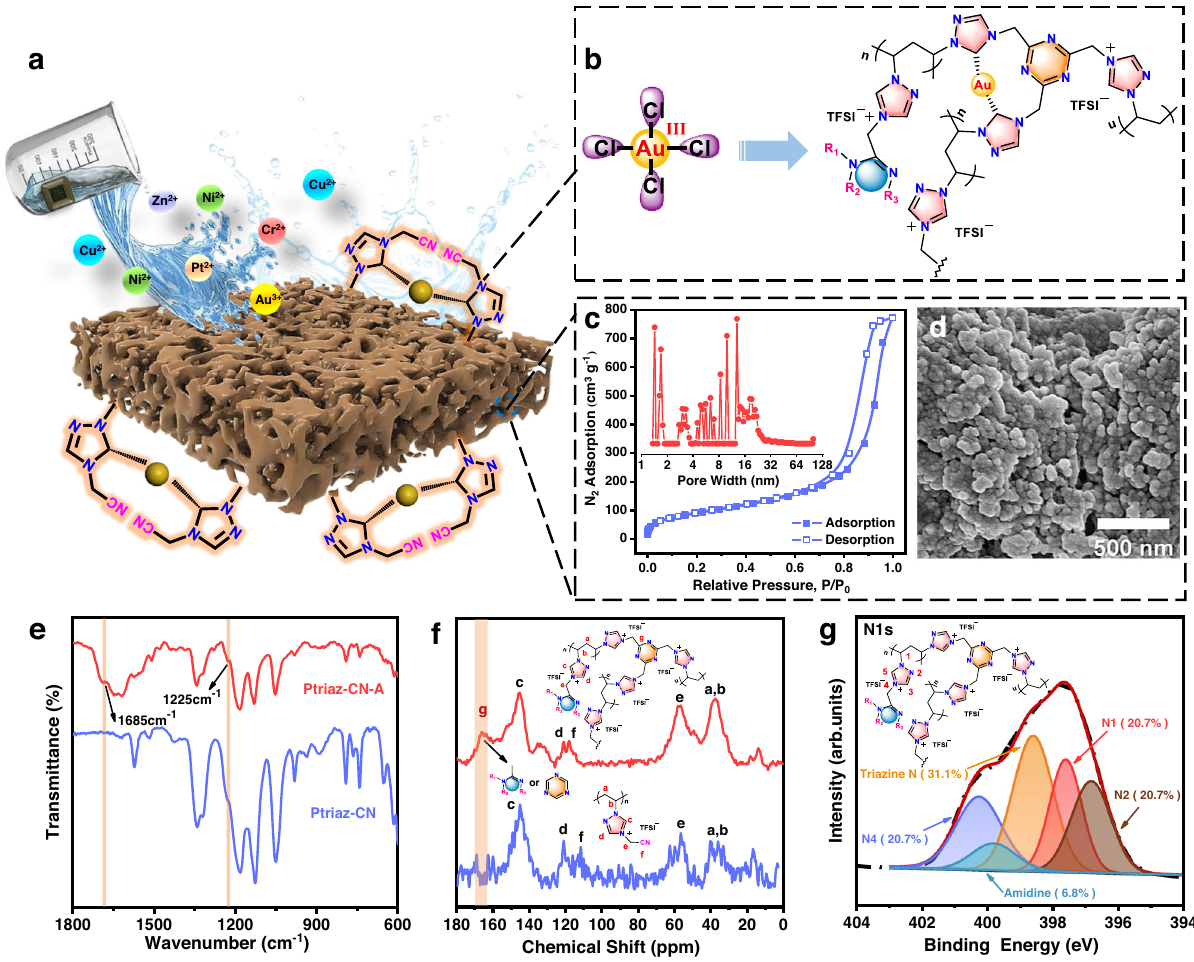
Fig. 1 | Schematic illustration of the 1,2,4-triazolium-based POPcarbene adsorbent (Ptriaz-CN-A) for gold recovery and characterization of Ptriaz-CN andPtriaz-CN-A.a SchemeofgoldrecoveryfromelectronicwastesbyPtriaz-CN-A via a wet-chemistry approach. b The mechanism of interaction between Au 3+ and crosslinkedPtriaz-CN-A. c Nitrogenadsorption-desorptionisothermsandporesize distribution plot of Ptriaz-CN-A. d SEM image of Ptriaz-CN-A. e FT-IR and f solid-